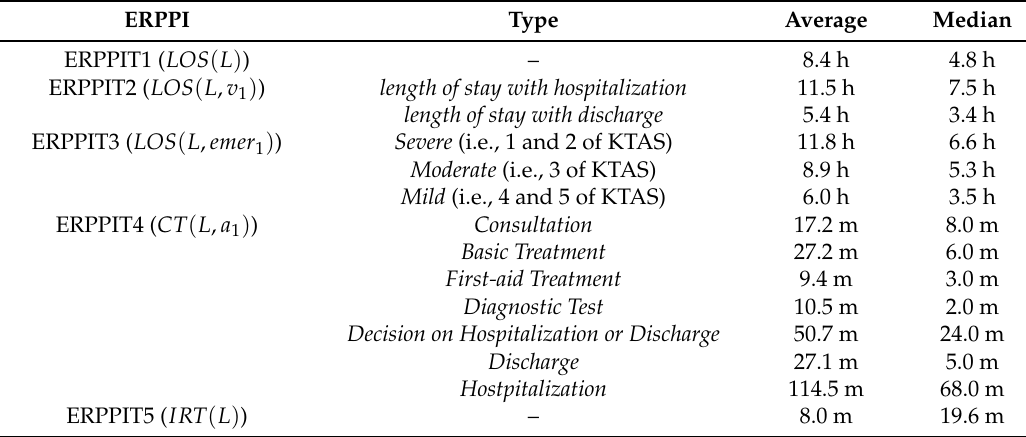
Table 2. Results for performance analysis applying